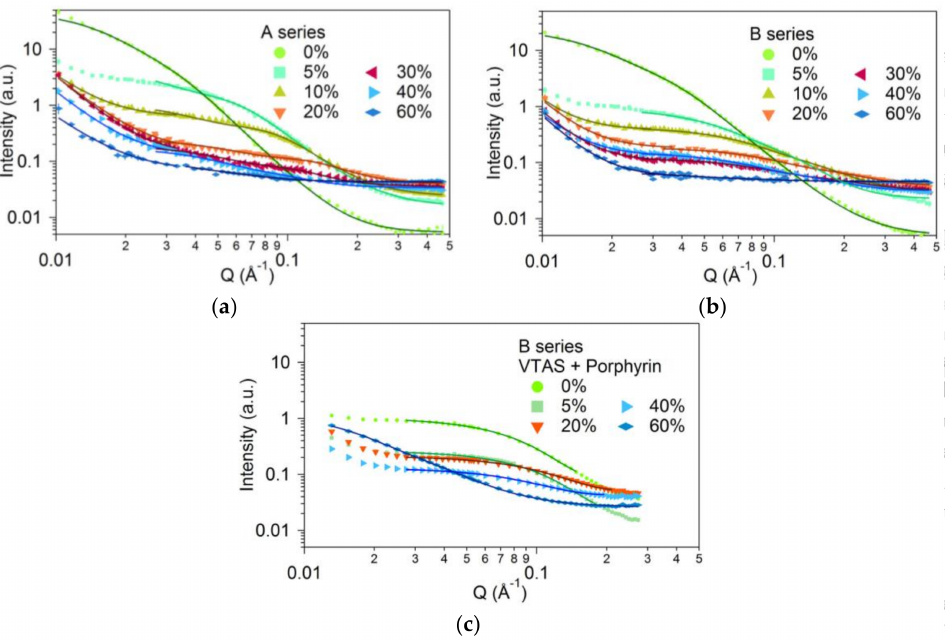
Figure 4. SANS curves of the measured A and B series of samples without ( a,b ) and with porphyrin ( c ). The percentages on the graphs refer to the molar ratio of